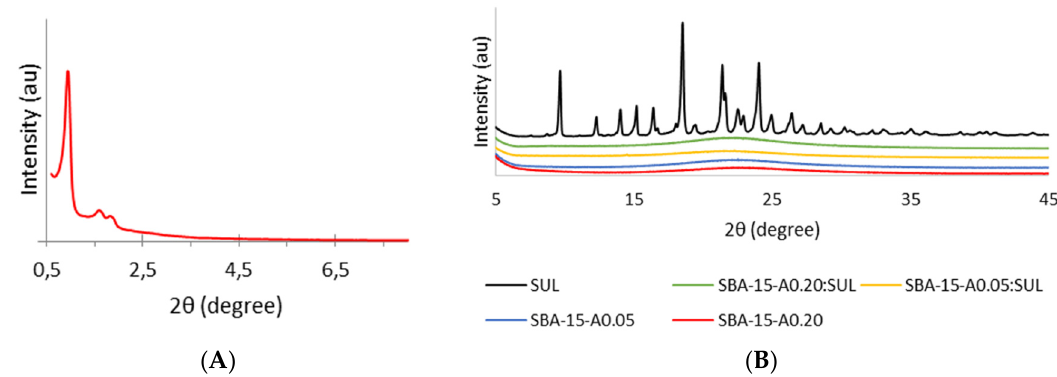
Figure 1. ( A ) Small ‐ angle XRD pattern of the SBA ‐ 15 ‐ A 0.20 ; ( B ) Wide ‐ angle XRD patterns of SUL, SBA ‐ 15 ‐ A 0.05 :SUL, SBA ‐ 15 ‐ A 0.20 :SUL, SBA ‐ 15 ‐ A 0.05 , and SBA ‐ 15 ‐ A 0.20